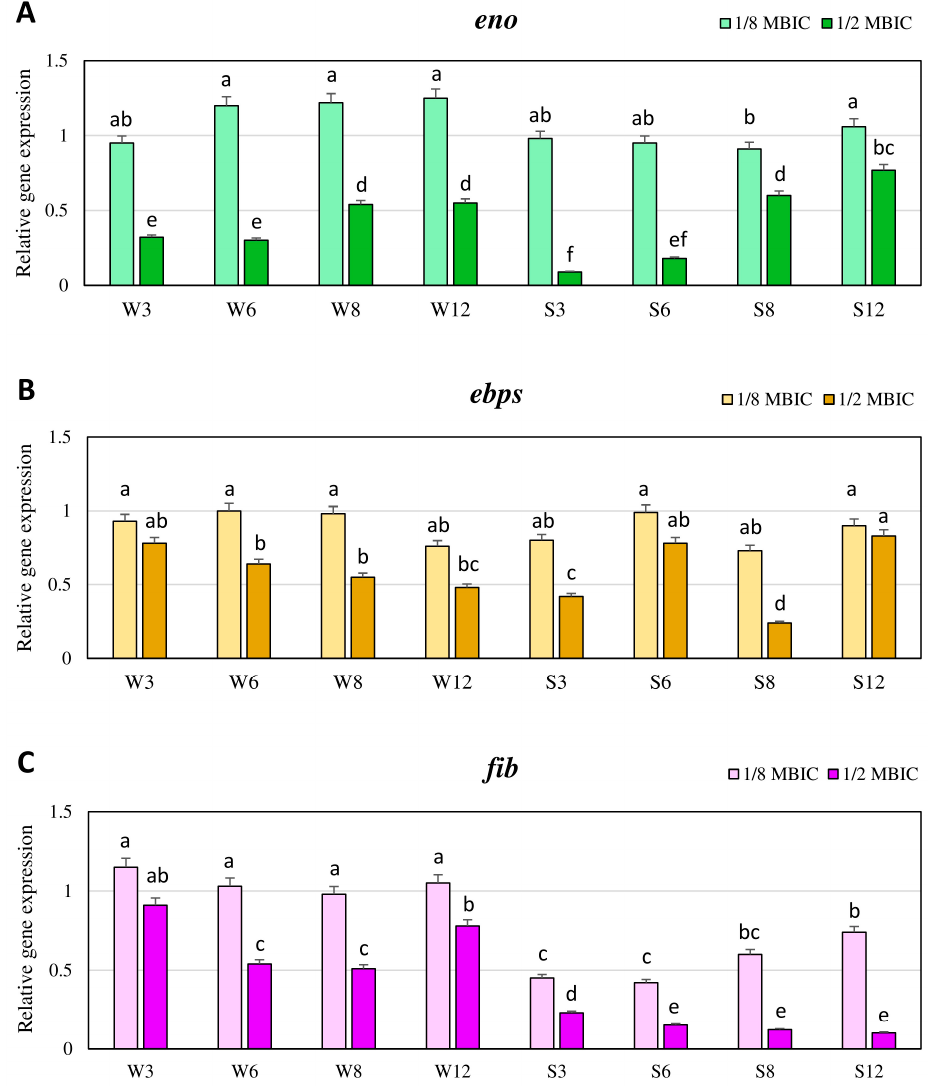
Figure 2. Transcriptional reprogramming of encoding laminin binding protein ( eno ) ( A ), elastin binding protein ( ebps ) ( B ) and fibrinogen binding protein ( fib ) ( C ) genes in MRSA strains treated with